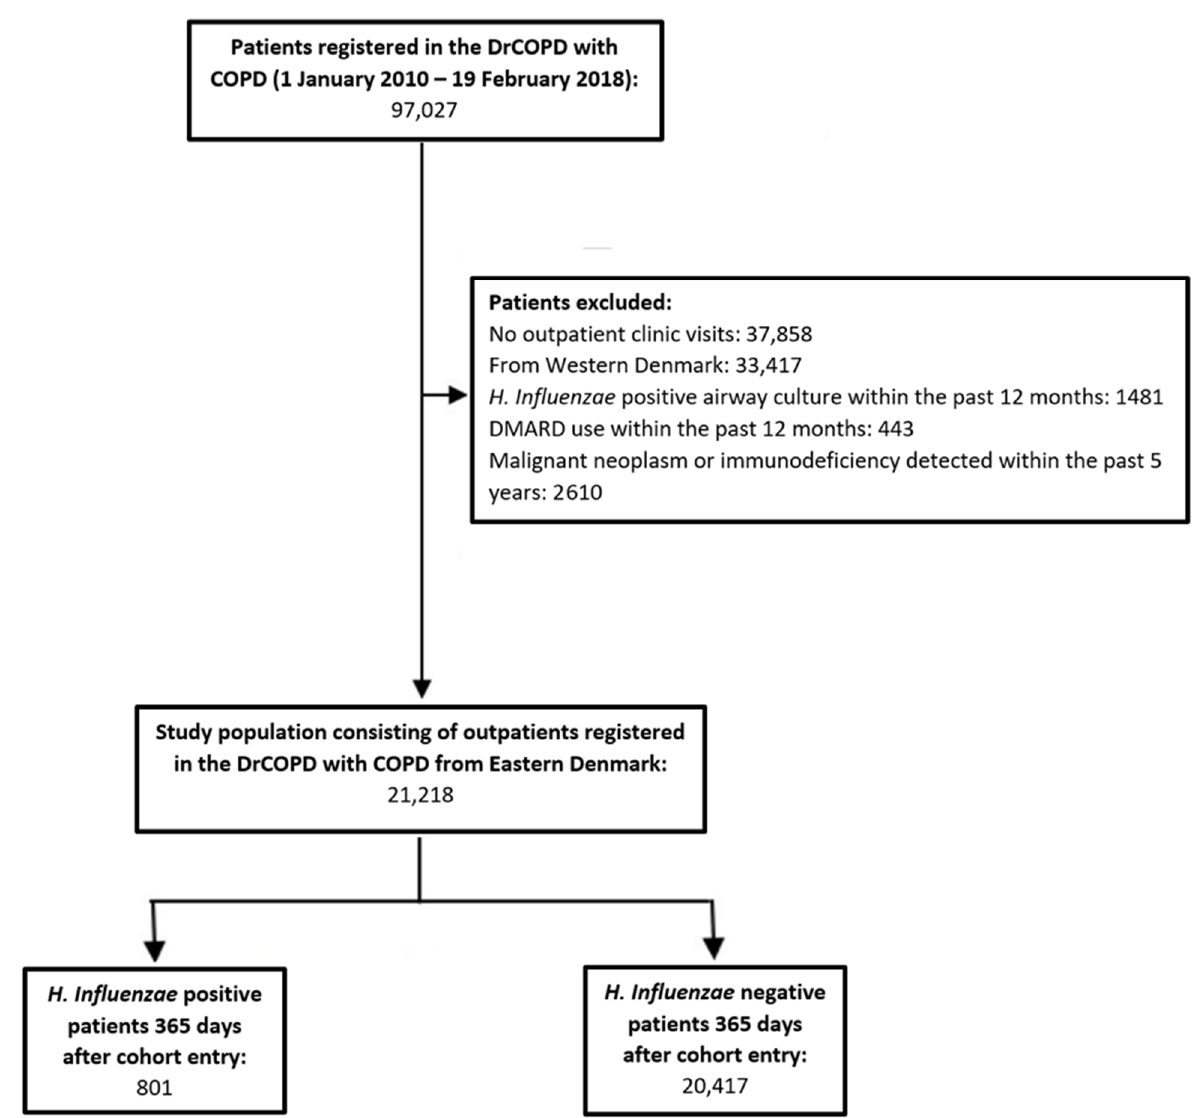
Figure 1. Study flow chart illustrating the patient selection criteria . After exclusion, the study population consisted of 21,218 patients, of which 801 acquired H. Influenzae during follow-up of 365 days. Abbreviations: Danish Register of Chronic Obstructive Pulmonary Disease (DrCOPD), disease-modifying anti-rheumatic drugs (DMARD), Haemophilus influenzae (H. Influenzae).